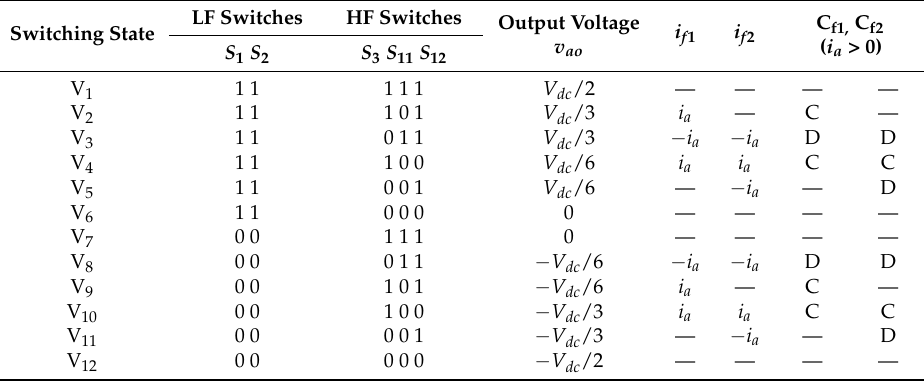
Table 7. Operation of 7L hybrid T-ANPC converter.